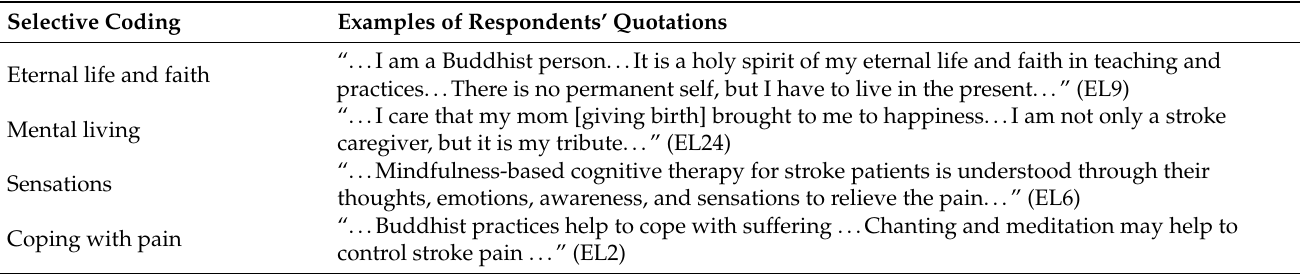
Table A3. An example of selective coding.